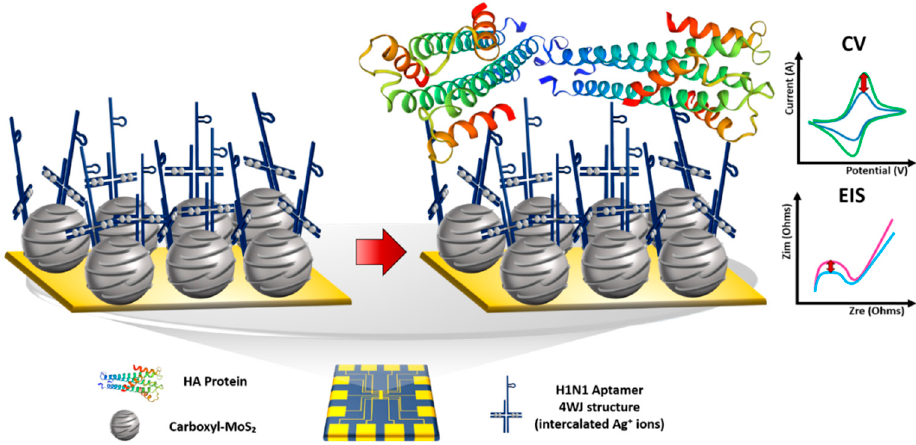
Figure 1. Schematic image of the fabricated electrochemical biosensor for H1N1